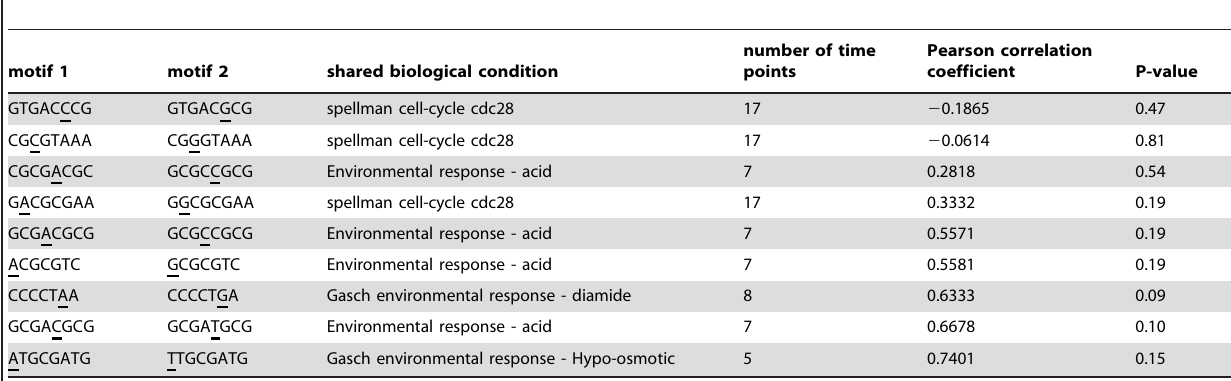
Table 1. Putative cases where a substitution causes a switch to a binding site that is active in the same condition as the ‘wild-